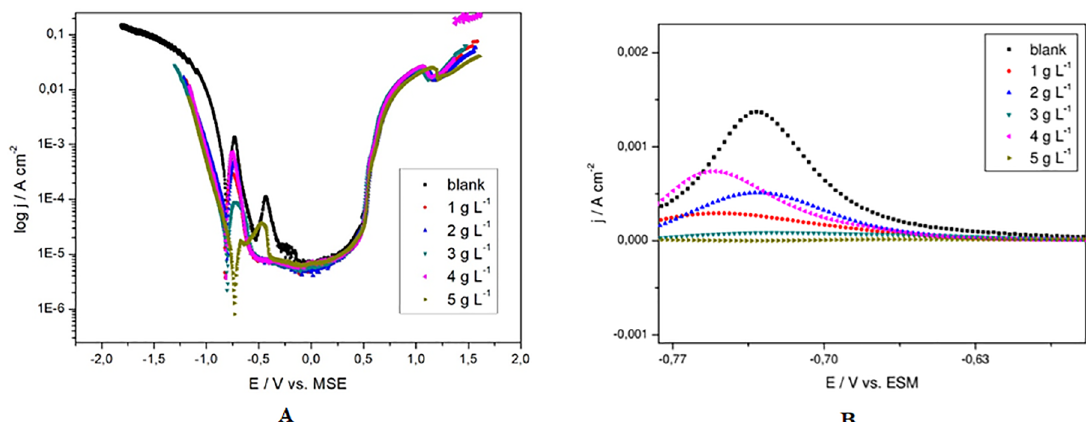
SO solution, in presence and absence of AEAW, 1 mV s -1 scanning rate; 2 4